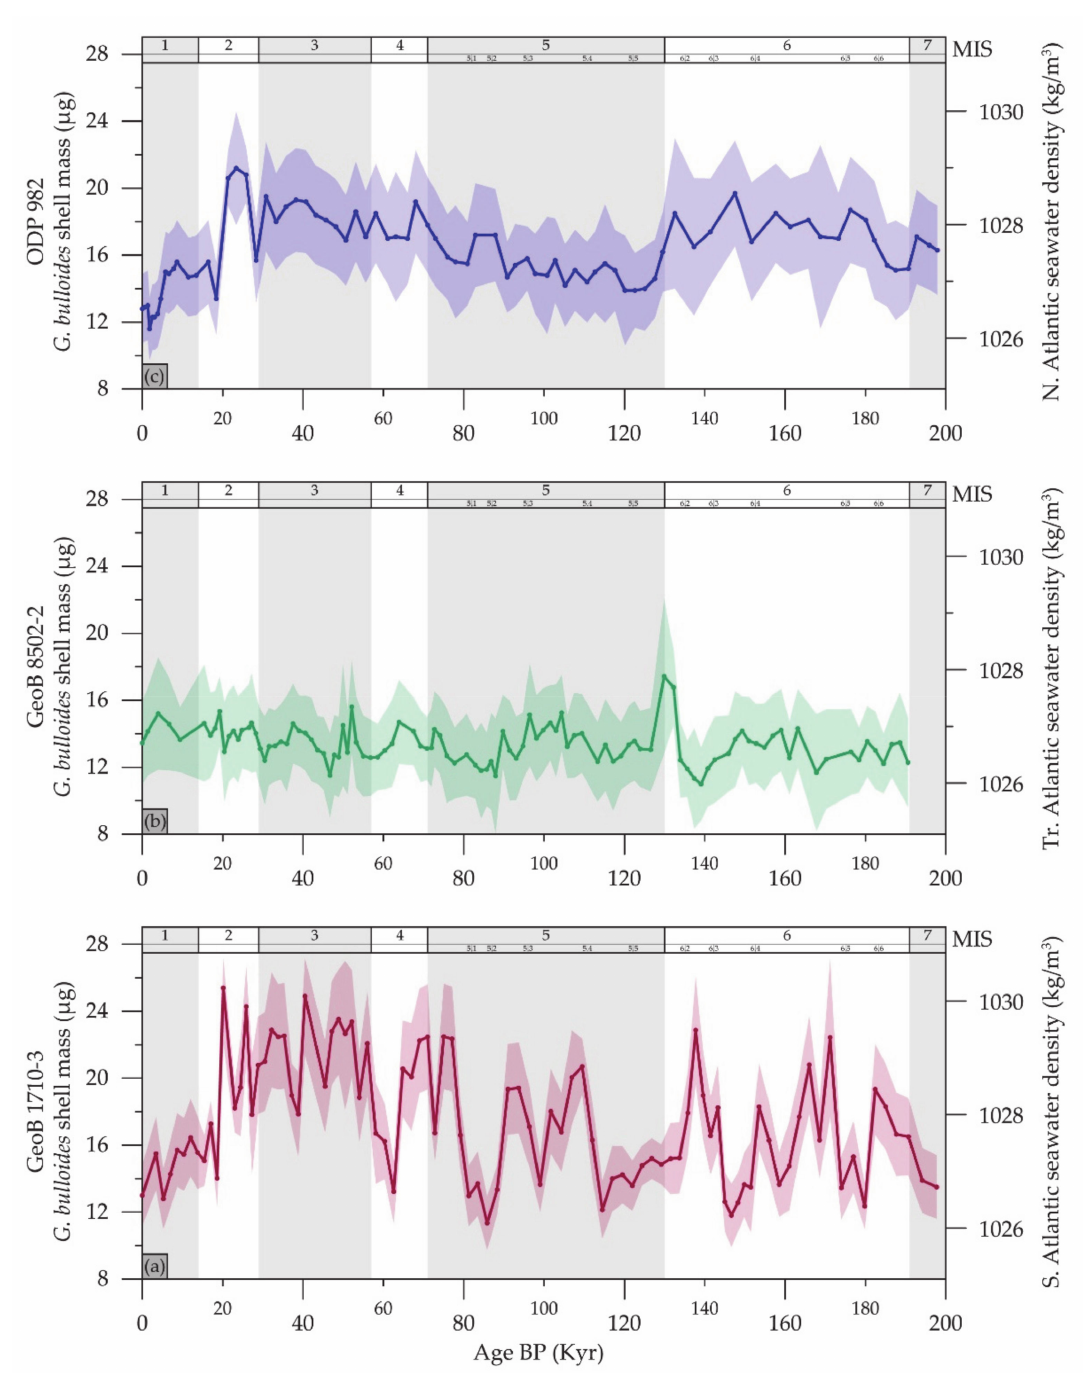
Figure 2. Shell weight records of the last 200 kyr (before present, BP) for: ( a ) core GeoB 1710-3 from the eastern South Atlantic; ( b ) core GeoB 8502-2 from the eastern Equatorial Atlantic [40]; and ( c ) core ODP 982 from the eastern North Atlantic. The 1 σ confidence interval for each shell mass plot is shown as a color-shaded area. Numbers refer to Marine Isotopic Stages (MIS) or substages and grey-shaded areas interglacial periods. Data are available in Supplementary Table